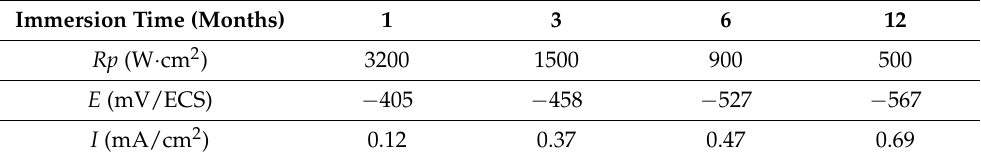
Table 5. Polarization resistance corrosion current and corrosion potential (for clay).